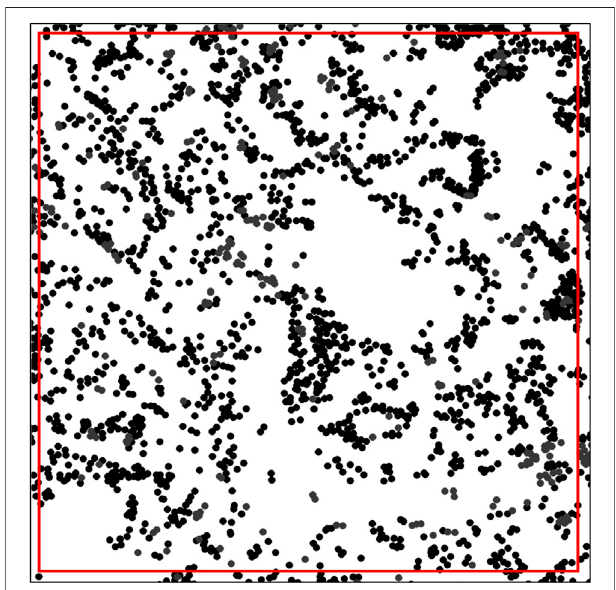
FIGURE4| Distributionofdotsrepresentingthecelldistributionpatterns in an image with edge correction, showing a square marked by a red line constructed using spatstats software in the R computing language. Only the dots inside the red line were considered in the analysis of the spatial distribution pattern. The image was generated using R studio software version